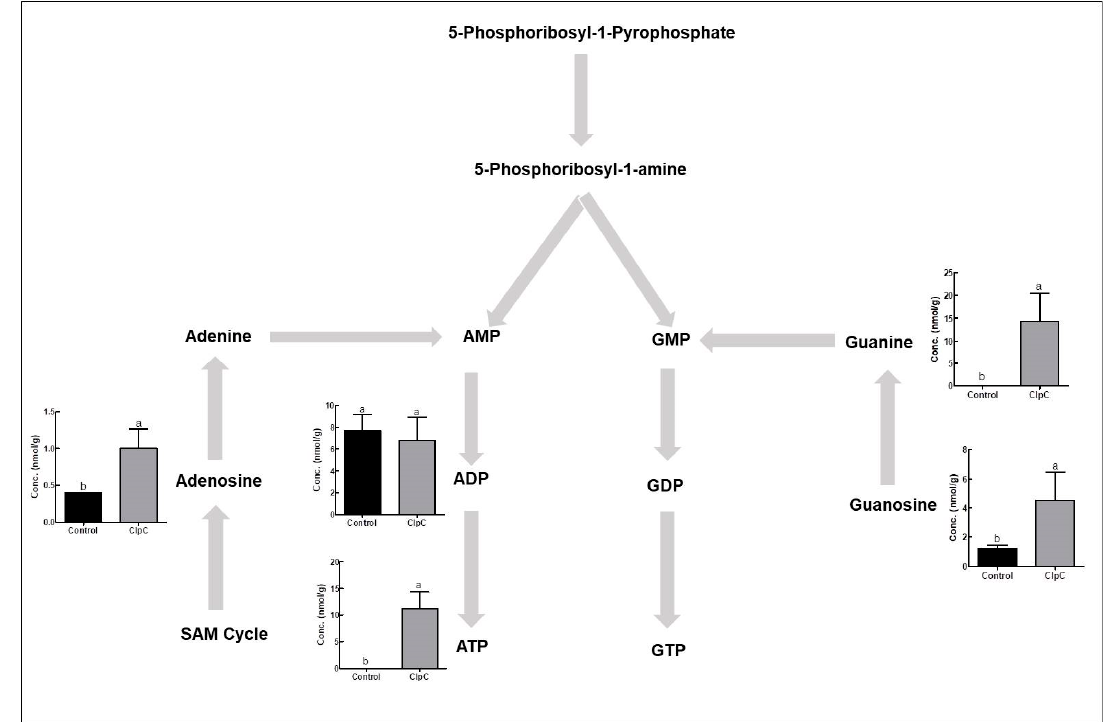
Figure 6. Changes in purine nucleotide biosynthetic pathway-related metabolite contents in Nicotiana benthamiana plants with co-suppression of NbClpC1 / C2. ClpC: NbClpC1 / C2 co-suppressed plants. The error bars indicate the SD of triplicate samples. The di ff erent letters on the bars indicate statistically significant di ff erences between groups ( p < 0.05).